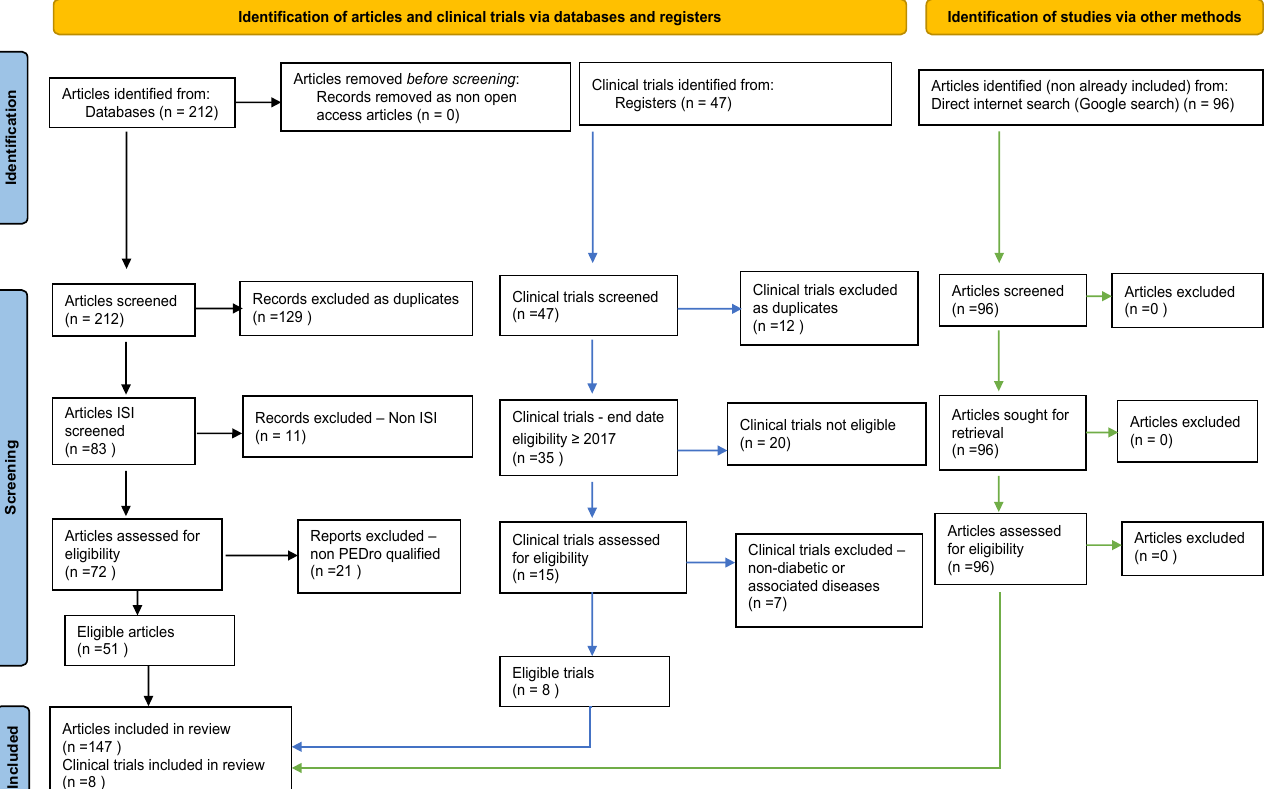
Figure 1. Our adapted PRISMA-type of the flow diagram. Table 2. PRISMA resulting conceptual skeleton structure of the article’s organization approach.